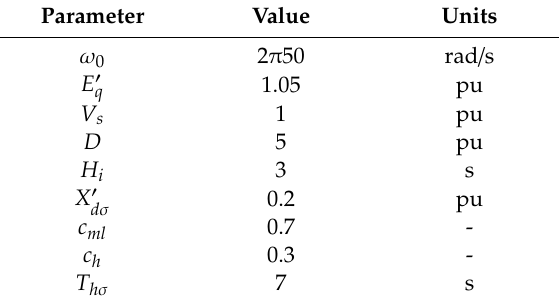
Table 1. Parameters of the systems under consideration.